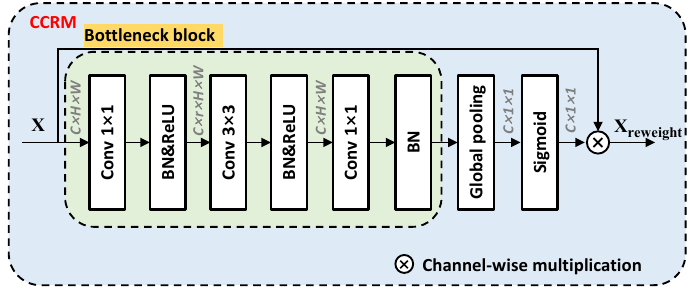
Figure 10. Detailed CCRM design of the Ir-UNet.